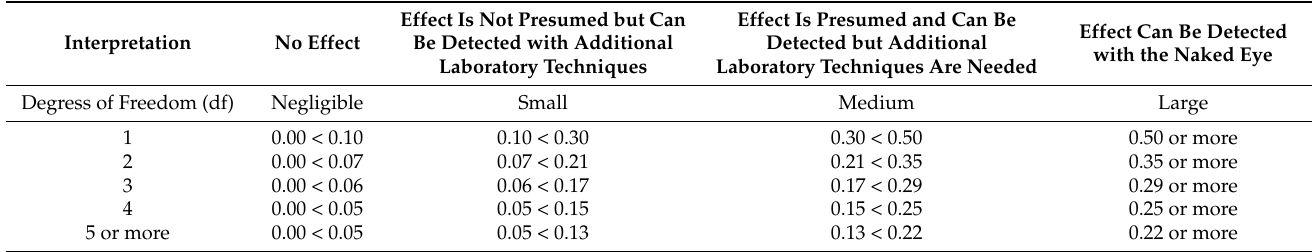
Table 2. Degrees of Freedom dependent interpretations for Cram é r’s V.